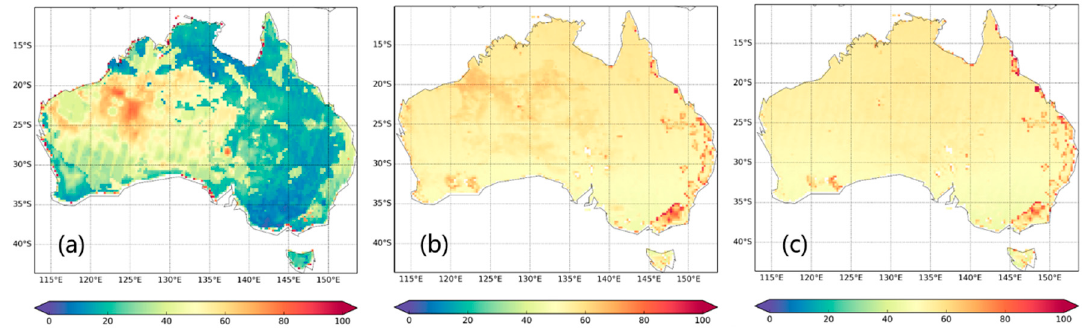
Figure 7. Percentage of data gaps of ( a ) ECV; ( b ) SMOSA; and ( c ) SMOSD soil moisture products from 1 January 2011 to 31 December 2012 over Australia.